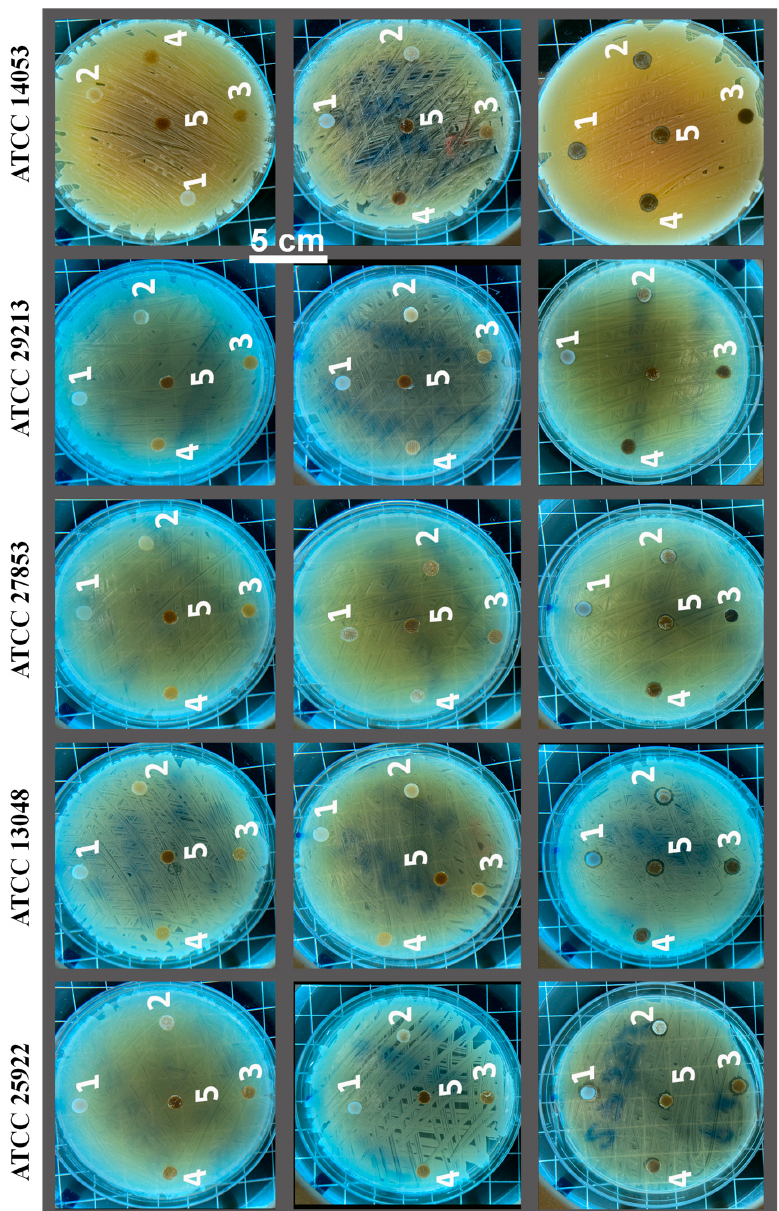
Figure 7. Representative inhibition zone of the composites coated by ZnO ( left ), Ag ( middle ), and Ag/ZnO ( right ) against Escherichia Coli (ATCC 25922), Klebsiella Aerogenes (ATCC 13048), Pseudomonas Aeruginosa (ATCC 27853), Staphylococcus Aureus (ATCC 29213), and Candida Albicans (ATCC 14053). The coded number 1–5 in the disk represents 0% (1), 0.5% (2), 1.5% (3), 2.5% (4), and 3.5% (5) of lignin in the